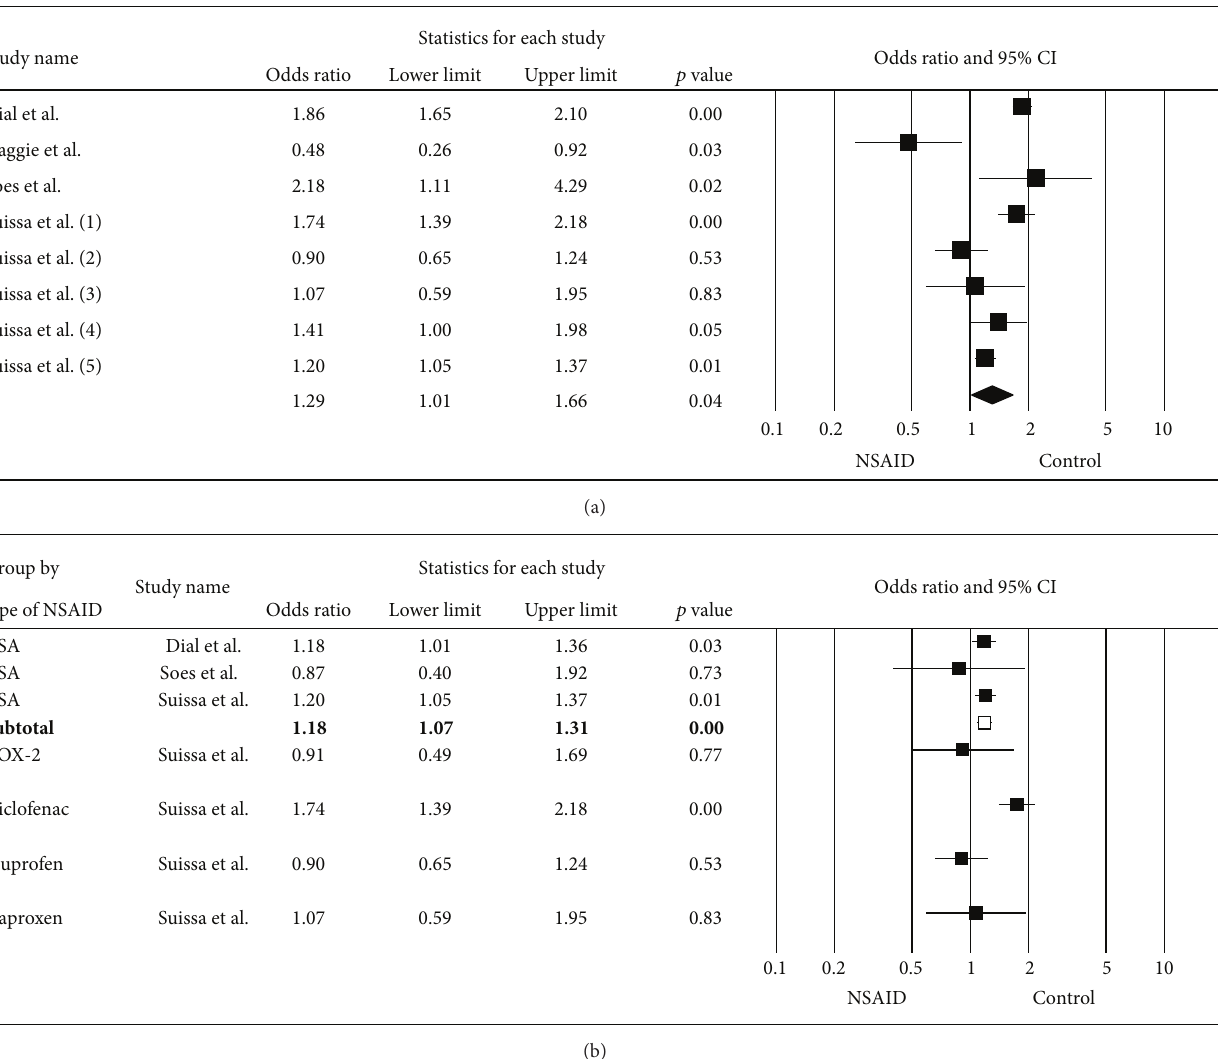
Figure 3: Forest plot of subgroup analysis in (a) nonselective NSAID and (b) each type of NSAID.